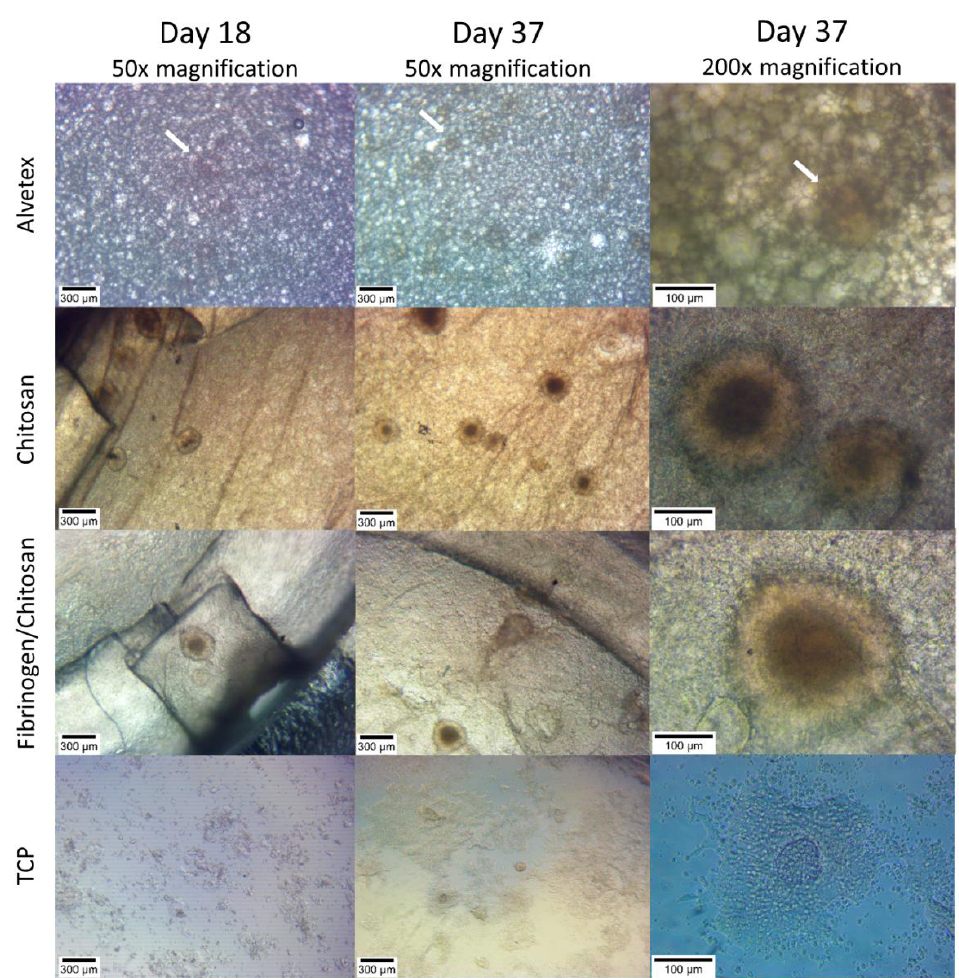
Figure 2. Formation of pseudoislets on 3D scaffolds. White arrows indicate poorly visible pseudoislet structures in Alvetex scaffold.